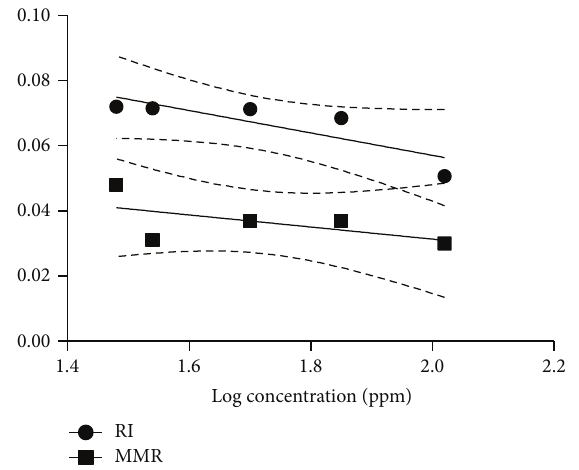
Figure 3: Reproductive index and mean egg mass per replicate in fullyengorgedadult R.(B.)microplus subjectedtodoseresponseAIT assay with deltamethrin.